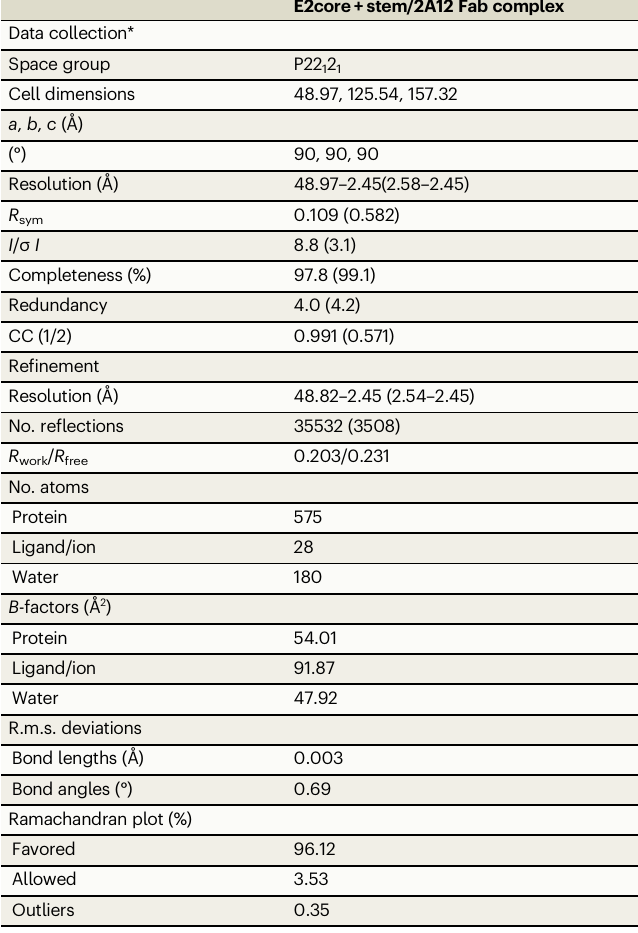
Table 1 | Data collection and re fi nement statistics